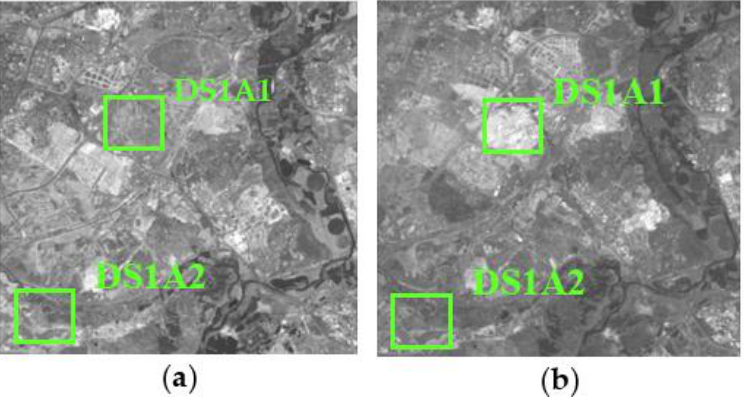
Figure 7. Data set 1 (DS1) with D1SA1 and DS1A2 highlighted subsets, radiometrically normalized images: ( a ) SPOT5 24 July 2005 reference image (master); ( b ) SPOT5 19 July 2008 normalized image (slave).